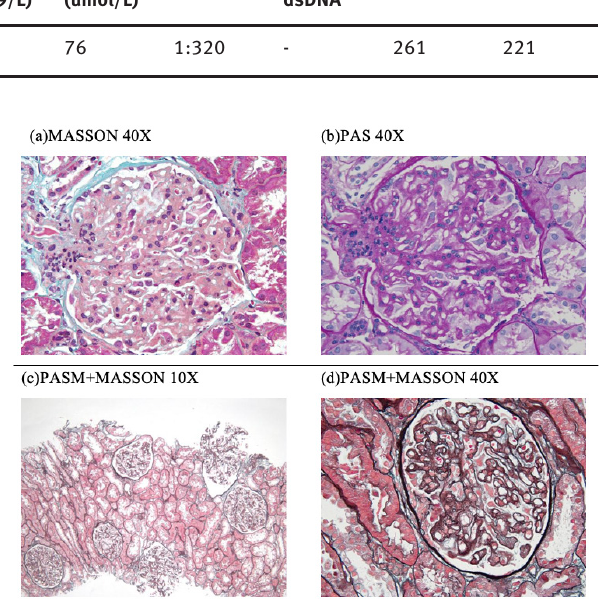
Table 1: Results of laboratory examination Index data